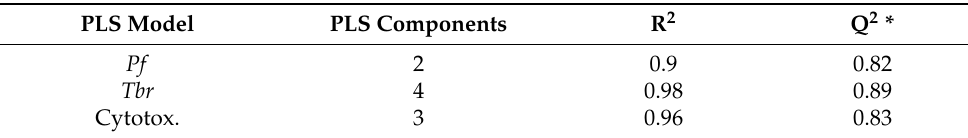
Table 2. Statistical characteristics of the three different PLS models.